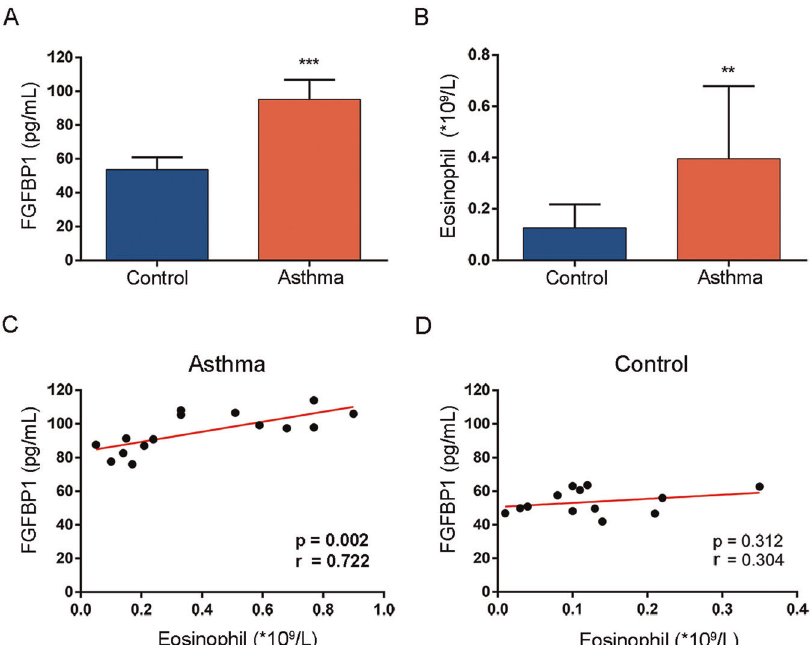
Fig. 2 FGFBP1 correlates to eosinophil count in asthmatic peripheral blood. A FGFBP1 protein levels in the peripheral blood of human subjects were quanti fi ed by ELISA. B Peripheral blood eosinophil counts of patients with asthma ( n = 13) and healthy controls without asthma ( n = 15) were obtained using an automated cell counter. C , D Pearson ’ s correlation scatter plot of the concentration of FGFBP1 and peripheral blood eosinophil count in asthmatic peripheral blood ( r = 0.722, P = 0.002; C ) and in participants without asthma ( r = 0.304, P = 0.312; D ). Results are shown as mean ± SD. ** P < 0.01; *** P <